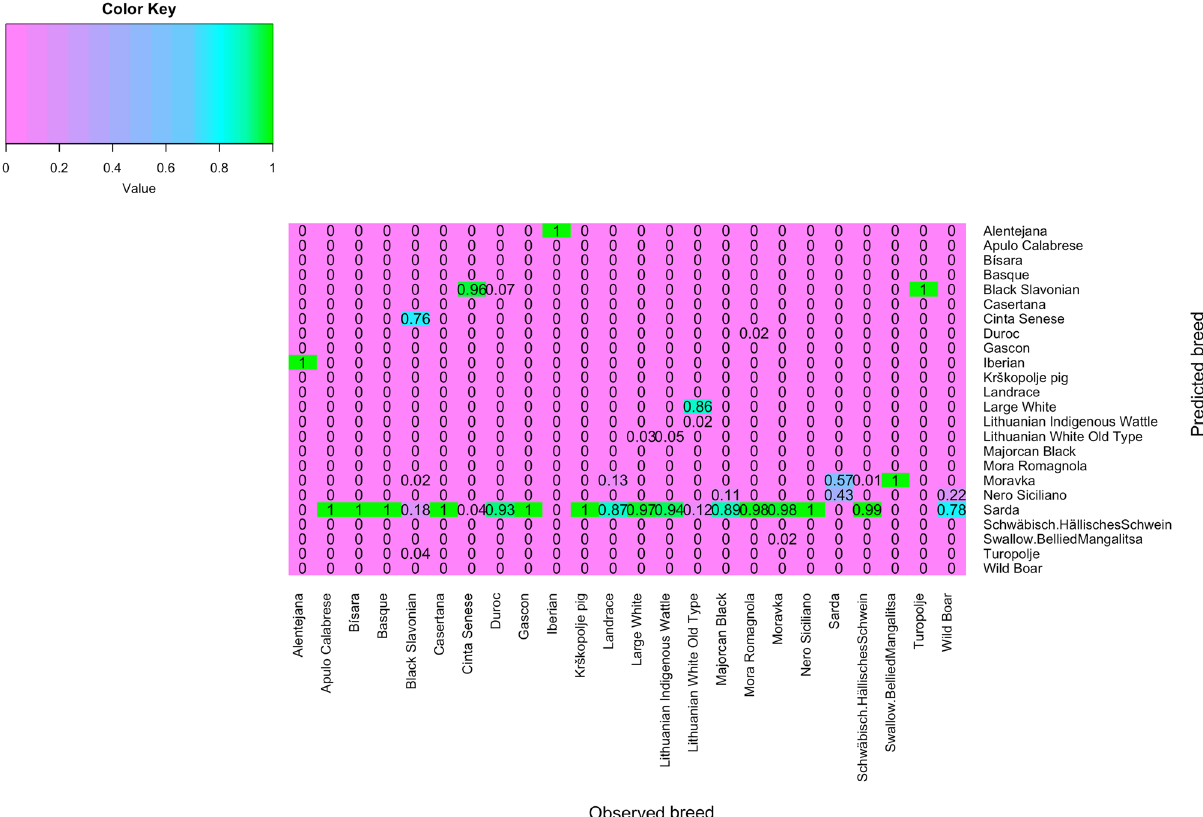
Figure 5. Heatmap of the DAPC assignment in the un-supervised scenario with percentage of external assignment per breed (in a scale of 0 to 1). Heatmap was constructed using the R 36 package gplots 37 and the function heatmap.2